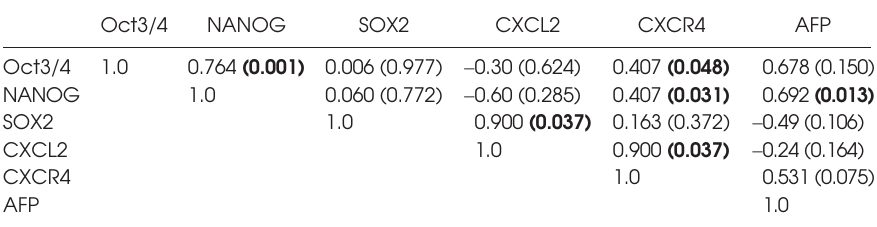
Table 1. Correlation analysis matrix of gene coexpression, shown as p values.